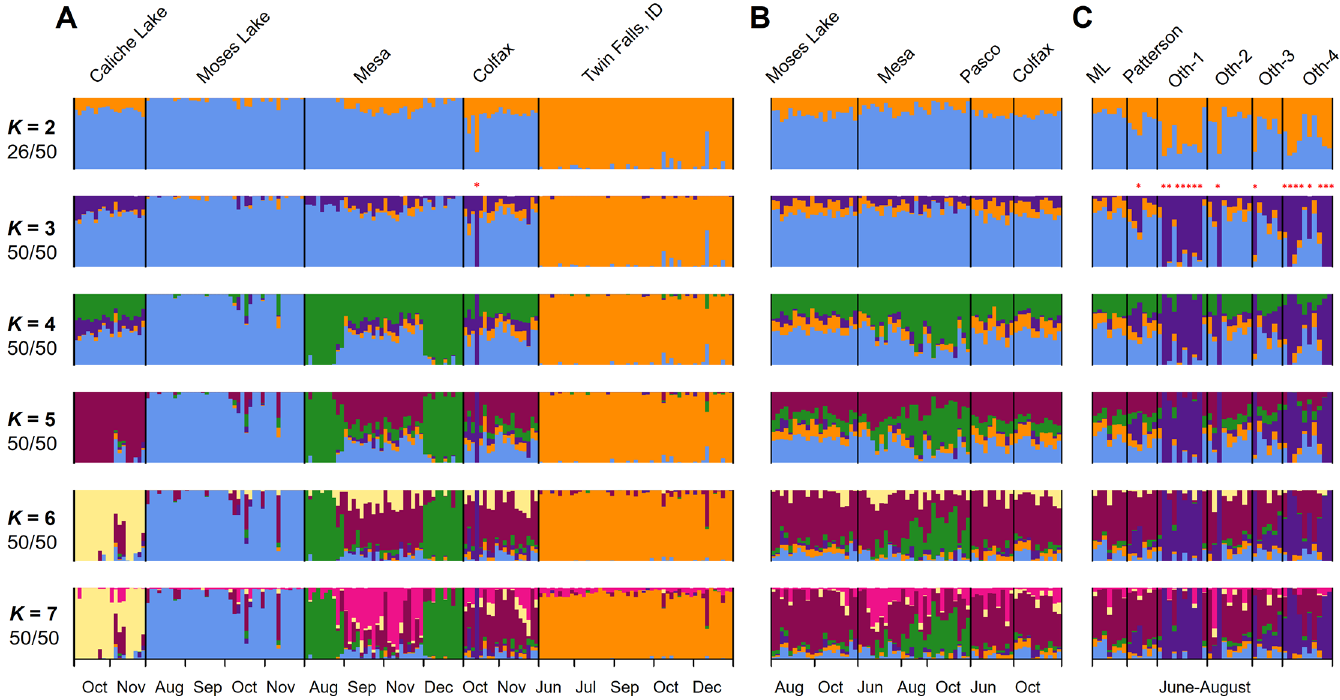
Fig 3. Estimated ancestryof potato psyllids collected from bittersweet nightshade patches and potatoes. Potato psyllidswere collectedfrom bittersweet nightshade patches in (A) 2012, (B) 2013, and from potato fields in (C) 2013. The number of ancestralpopulations( K ) rangedfrom K = 2 to K = 7, and only the groupingpattern that representsthe majority ( > 50%) of the runs were presented. Numbers beloweach K indicatethe number of runs (of 50 runs) showedthe representative grouping.Each vertical bar represents a psyllidindividual. * indicate“purple cluster” (assignedby majority-ruleat K = 3), a genetically distinct group which was further analyzedin